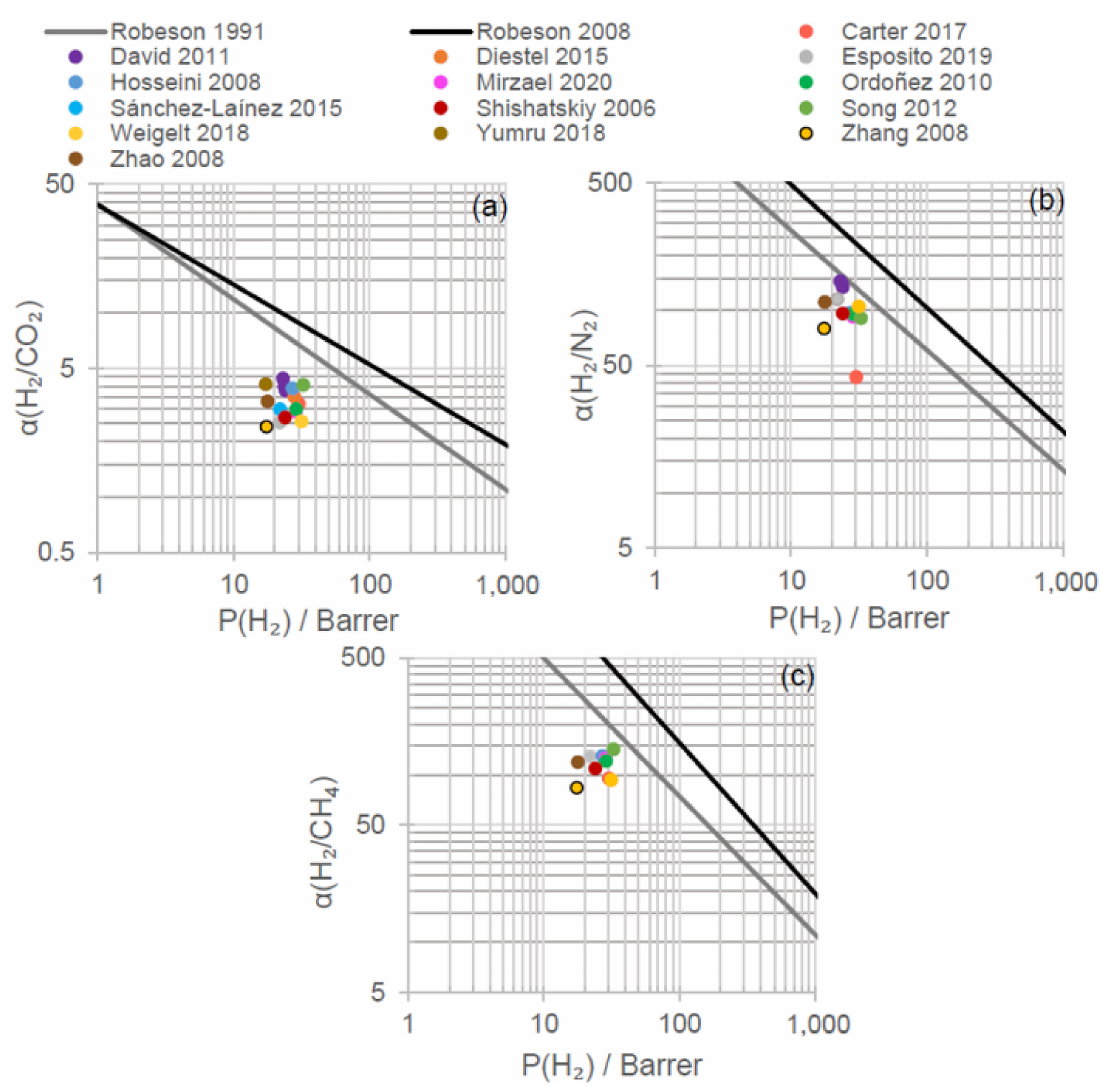
Figure 4. Robeson plot for ( a ) H 2 /CO 2 , ( b ) H 2 /N 2 and ( c ) H 2 /CH 4 single gas permeation tests through pristine Matrimid ® membranes. Reference correspondence is found at Table